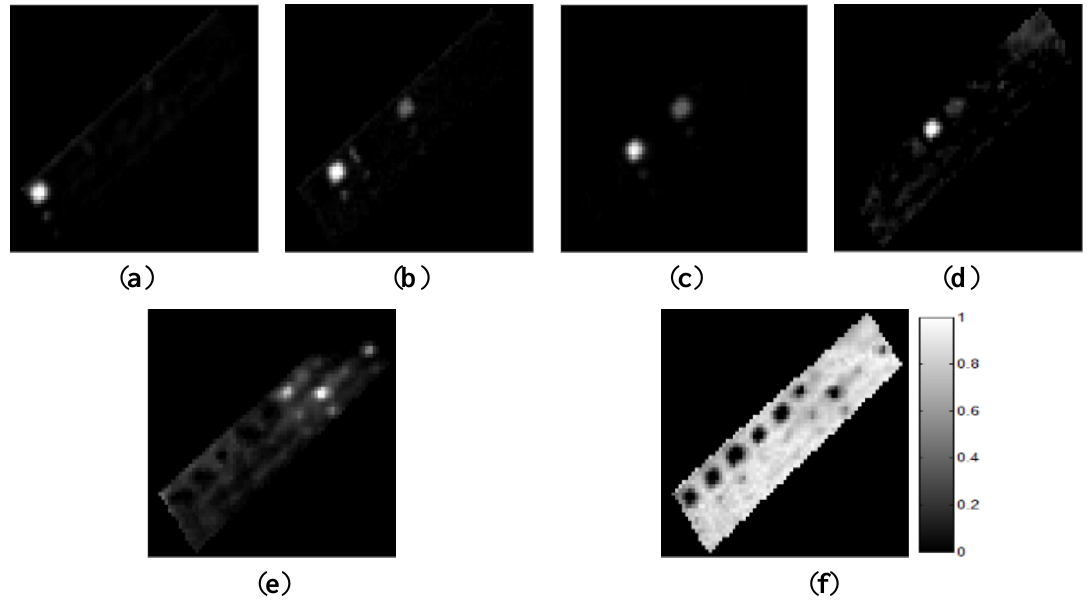
Figure 6. Abundance maps of ground-truth materials in the AISA data. ( a ) Grass; ( b ) Tartan